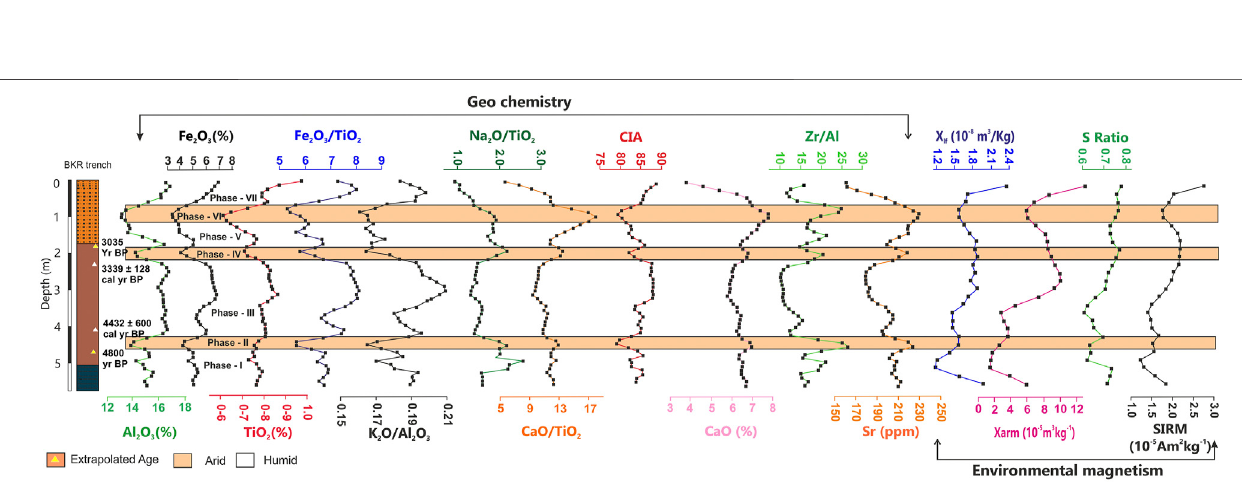
Frontiers in Earth Science |